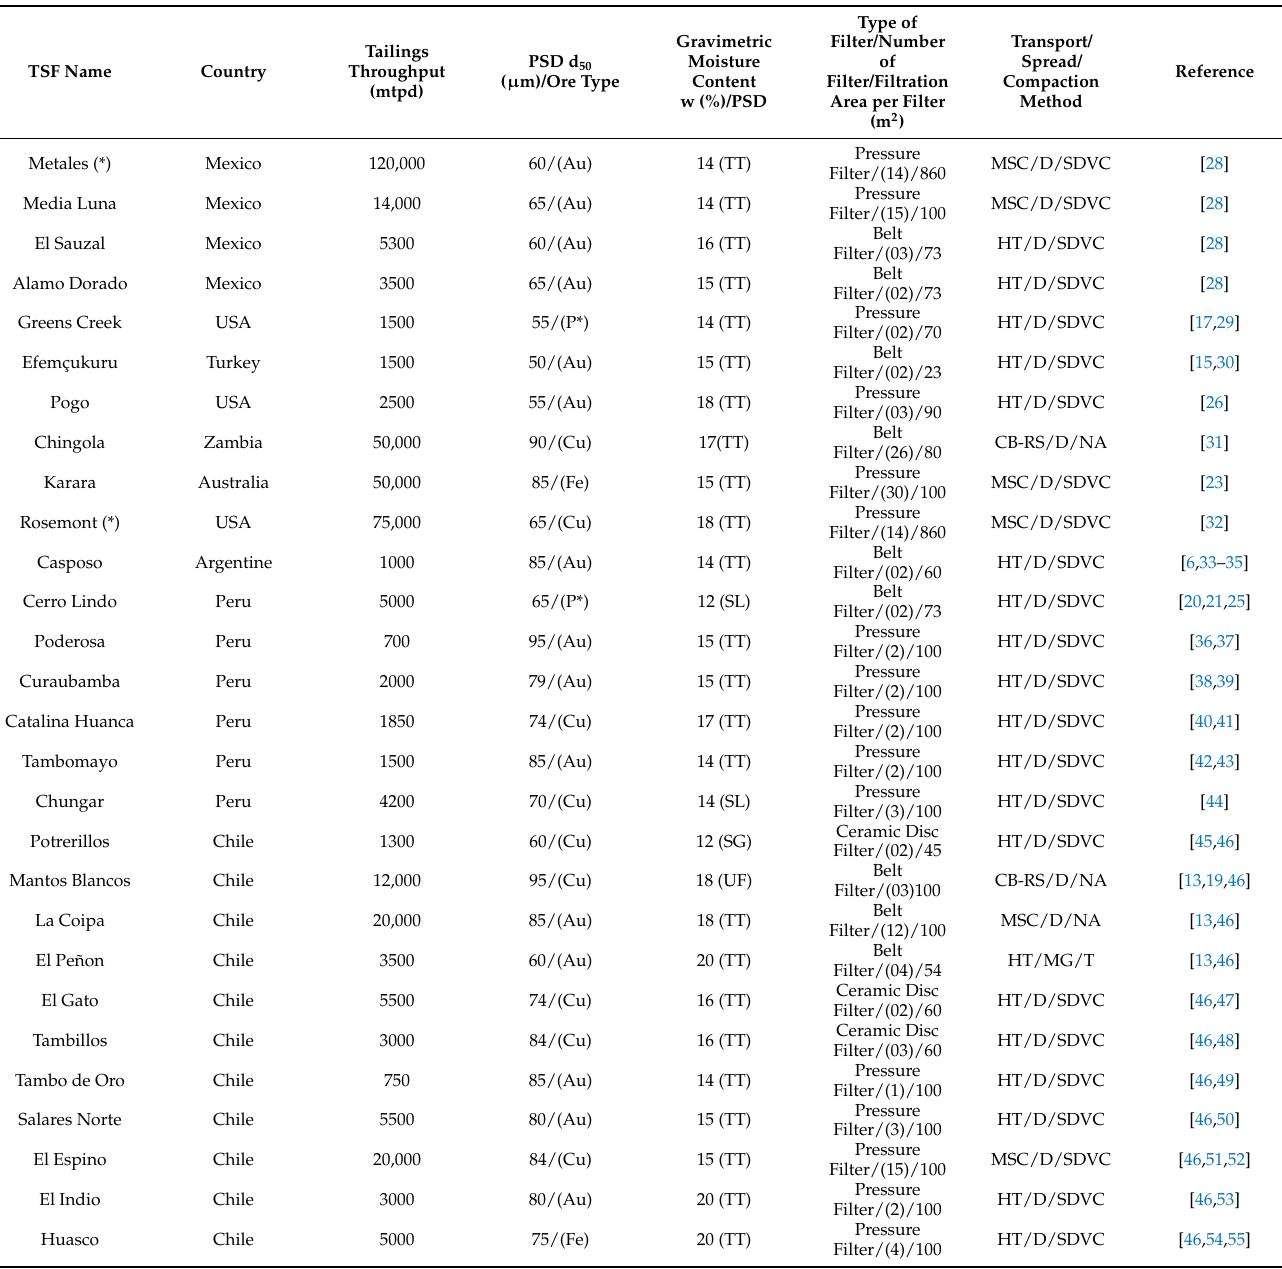
Table 3. Filtered Tailings Storage Facility Global